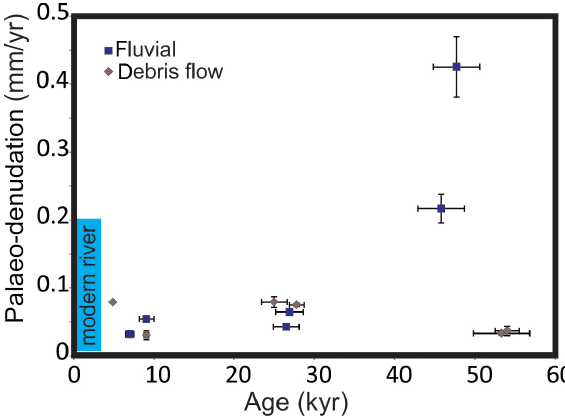
Figure 11. Accelerated erosion following initial deposition of de- bris flow material supports the idea of rapid stripping of a sta- ble regolith mantle. The initial high concentrations (low palaeo- denudation rates) for the debris flow deposits could represent long residence time on hillslopes, while the low concentrations (high palaeo-denudation rates) for the fluvial material could be the re- sult of rapid removal of the regolith cover (data after Abbühl et al., 2011; Bekaddour et al.,